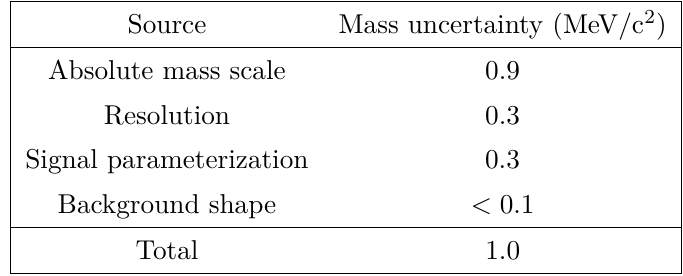
Table 2 . The systematic uncertainties for the ψ 2 (3823) mass